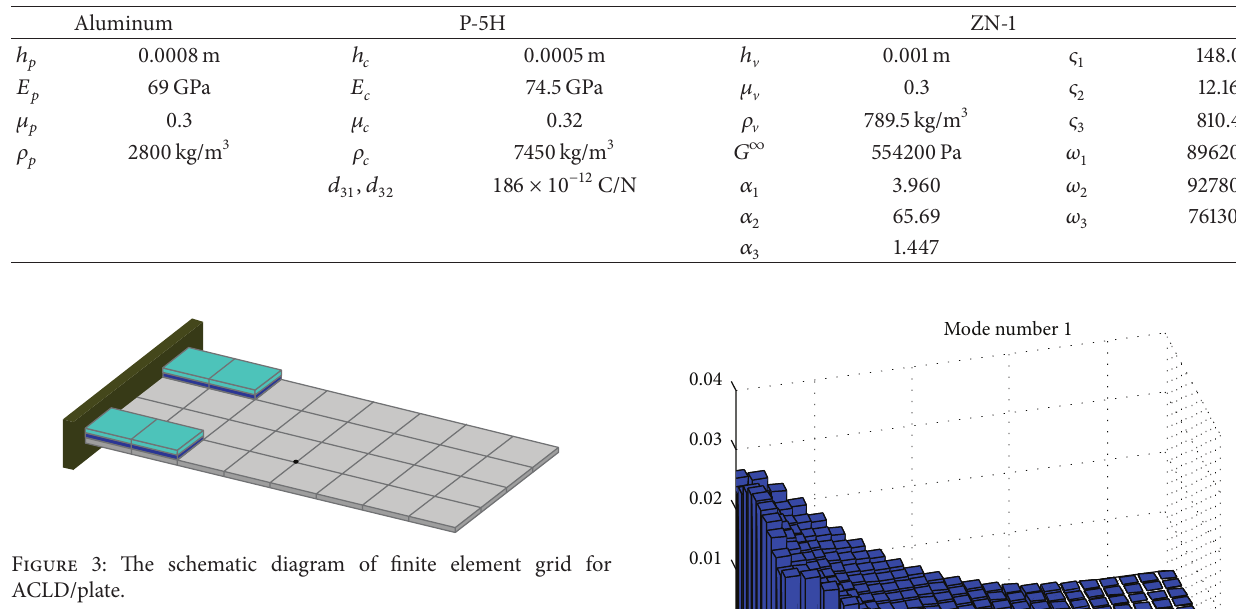
Table 1: Geometrical and physical parameters of ACLD/plate system.